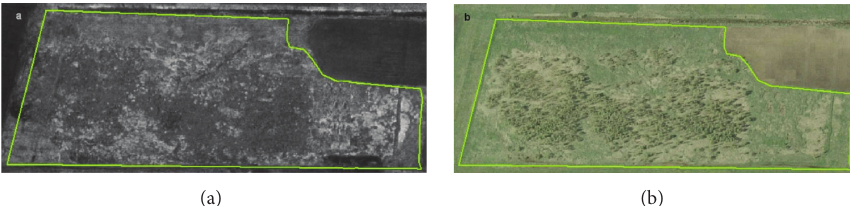
Figure 9: (a) The abundant, unused agricultural field in 1995 on the orthophoto image; (b) the same field in 2009 on the orthophoto image, but with the forest undergrowth.